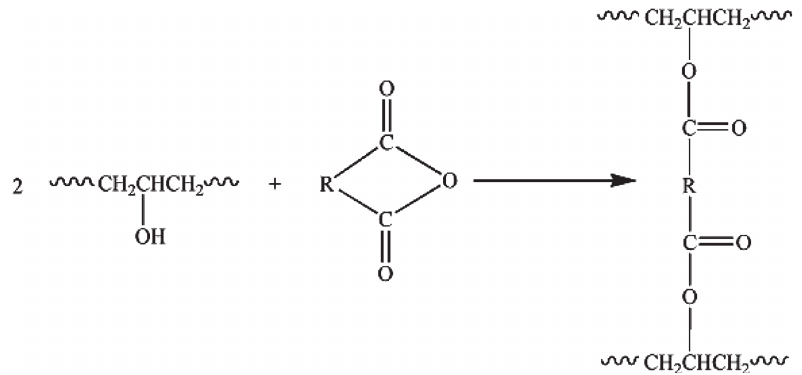
Figure 7: Curing reaction of bisphenol A epoxy resin and methyl tetrahydrophthalic anhydride.